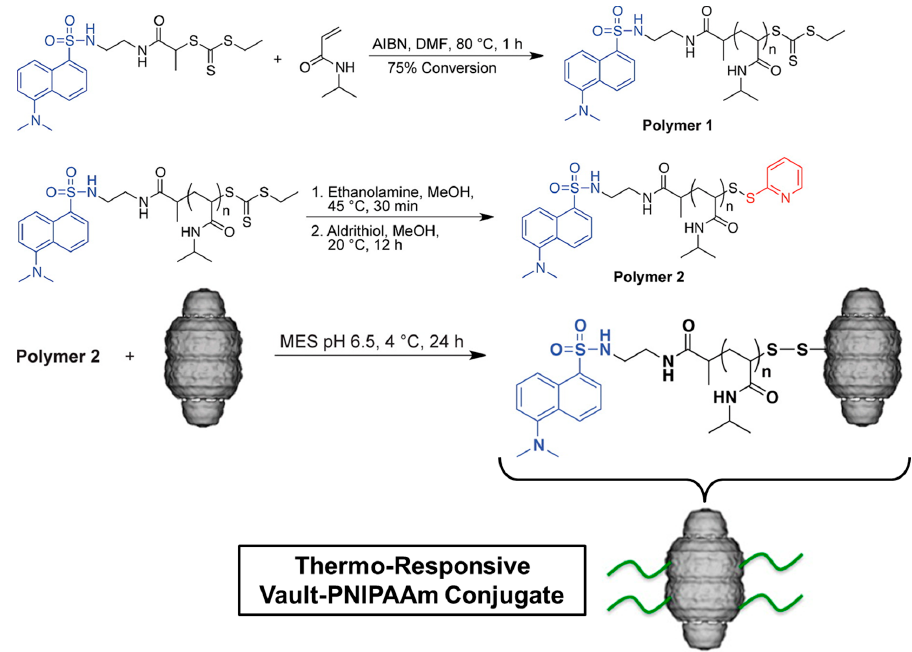
Figure 21. Scheme of the synthesis of thiol-reactive PNIPAAm polymer (Polymer 2) and reversible addition fragmentation chain transfer (RAFT) polymerization with CP-MVP vault. DMF: N,N -dimethylformamide; AIBN: azobisisobutyronitrile; MES: 2-( N -morpholino) ethanesulfonic acid). Adapted with permission from Reference [118]. Copyright © 2012 American Chemical Society.